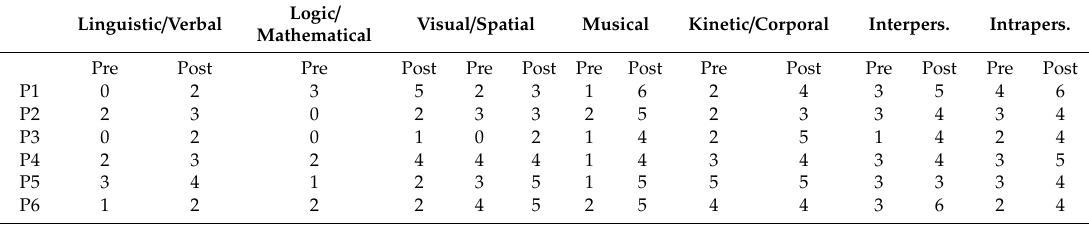
Table 2. Pre-test / post-test group results of the Seven Intelligences Test. Logic / Linguistic / Verbal Visual / Spatial Musical Kinetic / Corporal Interpers. Intrapers. Mathematical